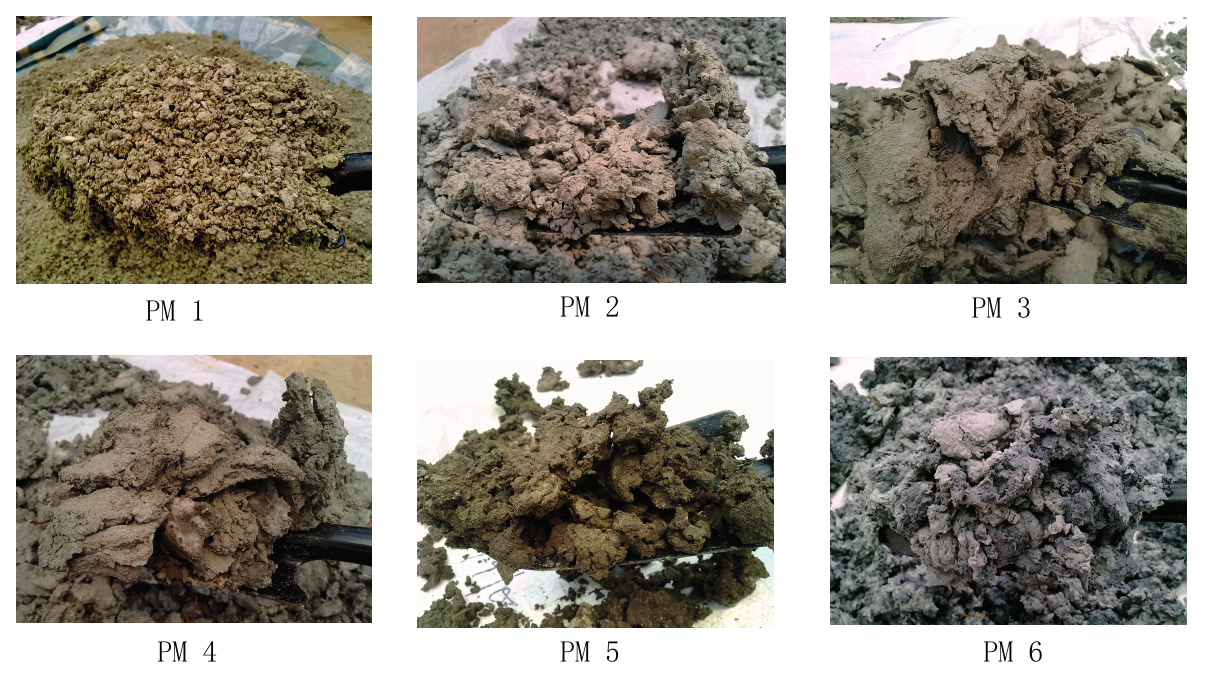
Figure 2. Physical appearances of different paper mill (PM) sludges from Peninsular Malaysia. The CEC values of paper mill sludges ranged from 3.33–28.07 cmol (+) kg –1 . Average CEC content is 14.43 cmol (+) kg –1 (Table 1). Reported CEC values of paper mill sludges from earlier studies varied widely from 5.3 to 297 cmol (+) kg –1 [15–19]. Differences in CEC may reflect differences in sludge composition, organic matter fraction and/or clay content